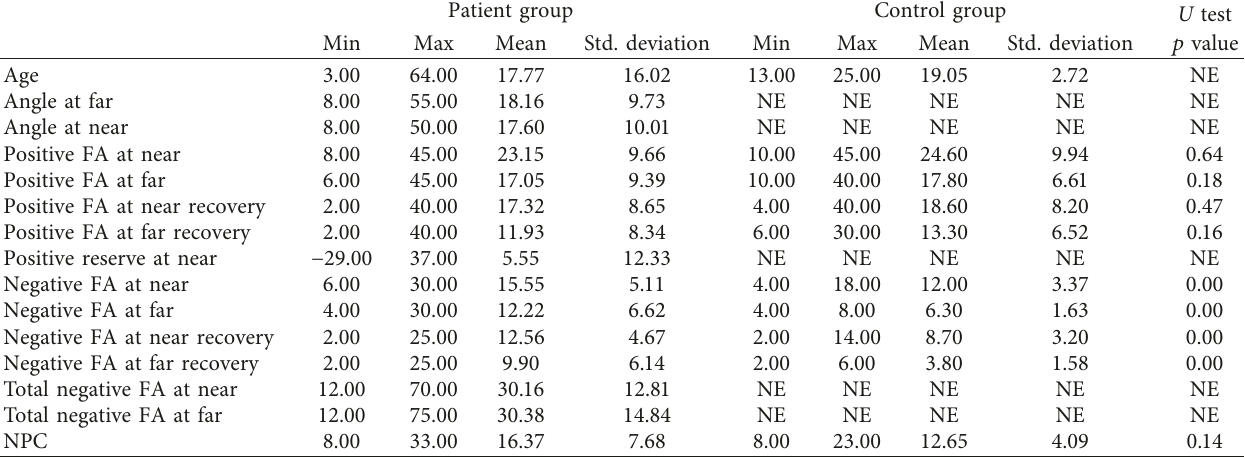
Table 1: Group A: descriptive statistics for patient group and control group (Mann–Whitney U test).